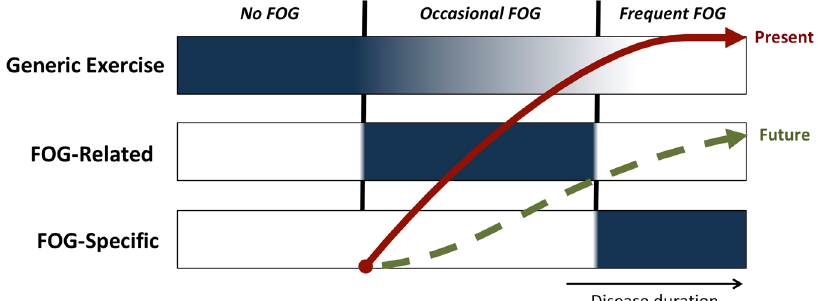
Fig. 11 Theoretical framework for selecting the type of exercise/training in PD using a simple selection criteria, namely the self-reported frequency of FOG. Blue shaded areas indicate when this category of intervention is recommended. The red arrow represents the current progression of worsening FOG severity. The green dotted arrow represents the hypothesized attenuated progression of FOG severity that may be achieved by following this framework. Note that the intensity of generic exercise will likely need to be reduced when FOG-related interventions are offered due to time, energy, and resource constraints. There will also be an increasing need for supervised training by a therapist as the disease progresses and FOG becomes more